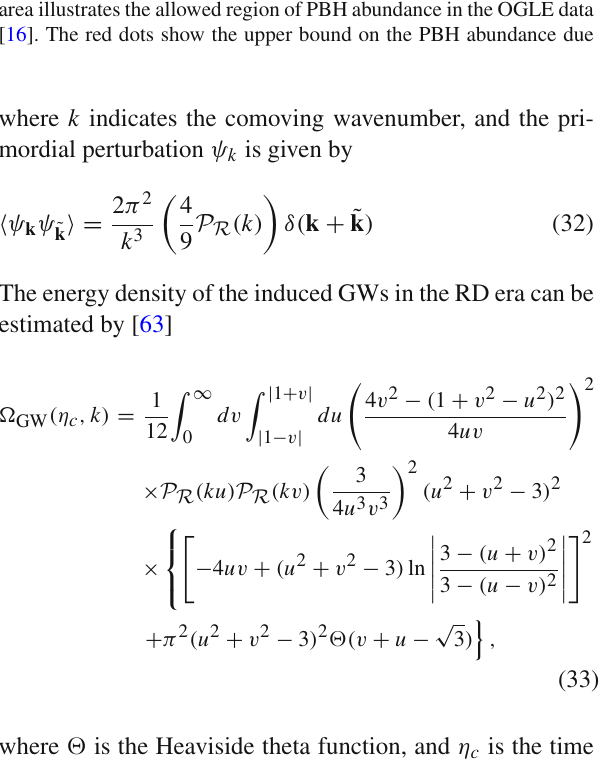
to the upper limit on the LIGO event merger rate [17]. Other shaded regionspresenttherecentobservationalconstraintscontainingaccretion constraintsfromCMB[18,19],withEROS/MACHO(EROS/MACHO) [20], with the Kepler satellite (Kepler) [21], microlensing events with Subaru HSC (Subaru HSC) [22], white dwarf explosion (WD) [23], femtolensingofgamma-rayburst(Femto)[24]andextragalacticgamma rays from PBH evaporation (EG γ )